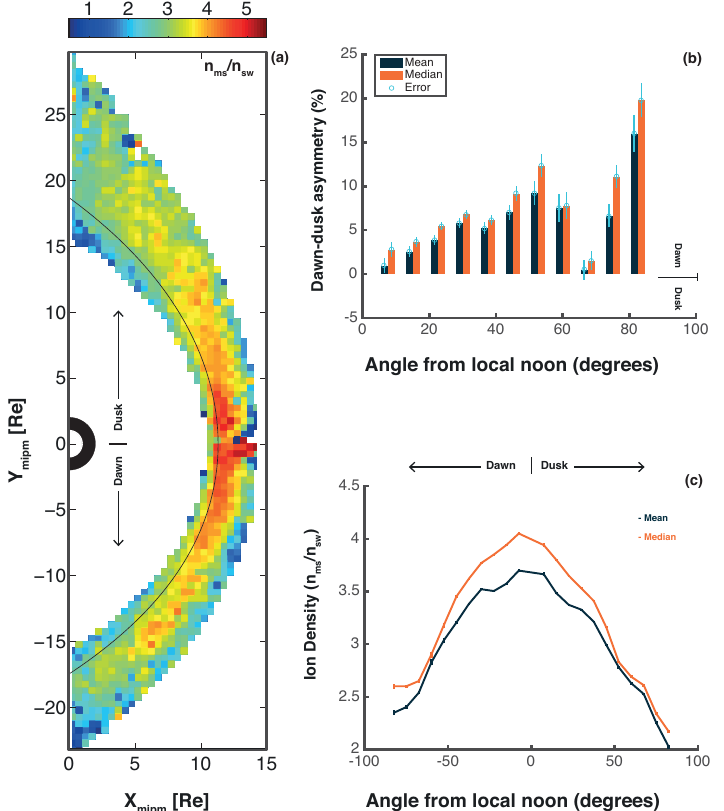
Figure 3. Statistical data of ion number density collected in the dayside magnetosheath. Panel (a) is a statistical map whereas presented in panels (b) and (c) are the dawn–dusk asymmetry and cross sectional cuts, respectively. Please note: 1. All densities are normalised by their individual upstream counterpart. 2. The cuts and asymmetry are estimated over the fractional distance range of 0 to 0.2, i.e. between the magnetopause and the black line. 3. Error-bars correspond to maximum variation of asymmetry and parameter value from the standard error √ n about the mean SEM = σ/